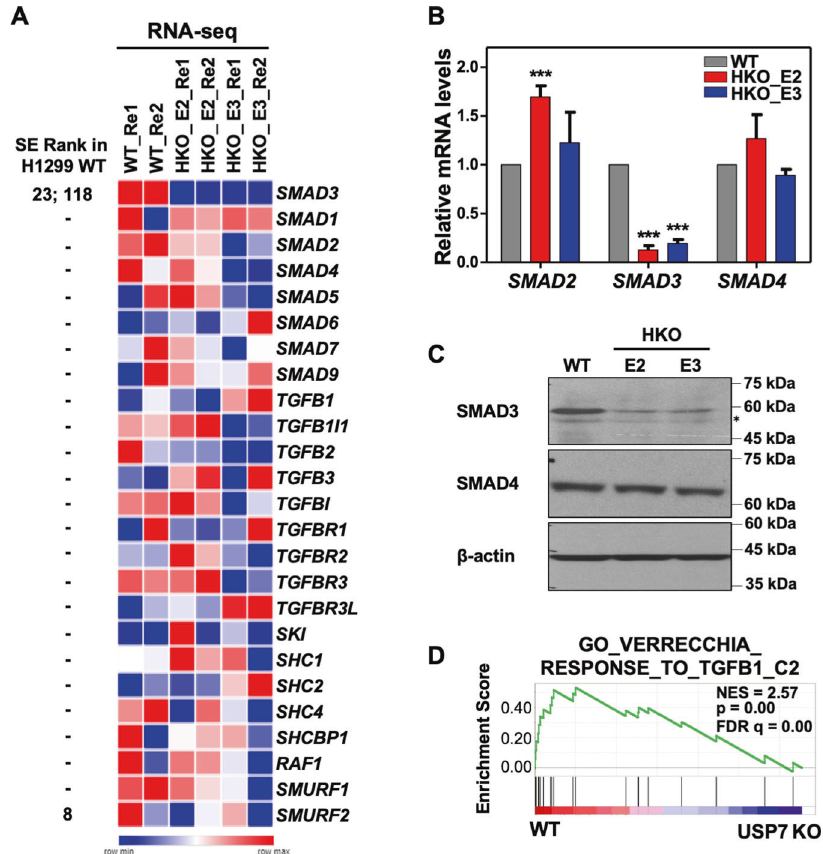
Fig. 3 USP7 is speci fi cally required for the expression of SMAD3 in H1299 cells. A Heatmaps of RNA-seq results showing the relative expression levels of genes involved in TGF β -signal pathway in wildtype (WT) and USP7 KO (HKO_E2 and HKO_E3) H1299 lines. Two biological repeats for each line and rank in wildtype SE identi fi cation are shown. B RT-qPCR assays showing the relative expression levels of indicated genes in wildtype (WT) or USP7 KO (HKO_E2 and HKO_E3) H1299 cell lines. Means ± SD from three biological experiments are